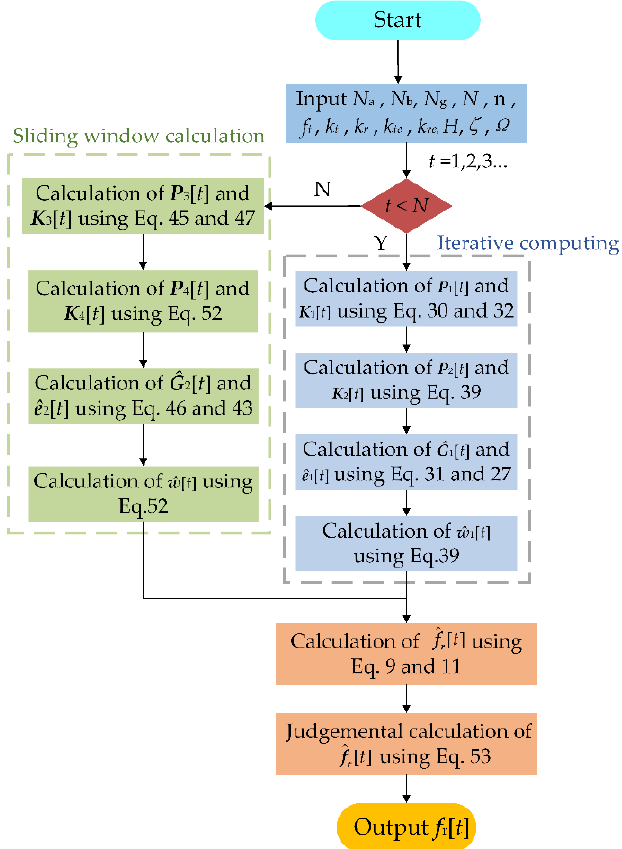
Figure 2. Flow chart of the algorithm for estimating the modal parameters.